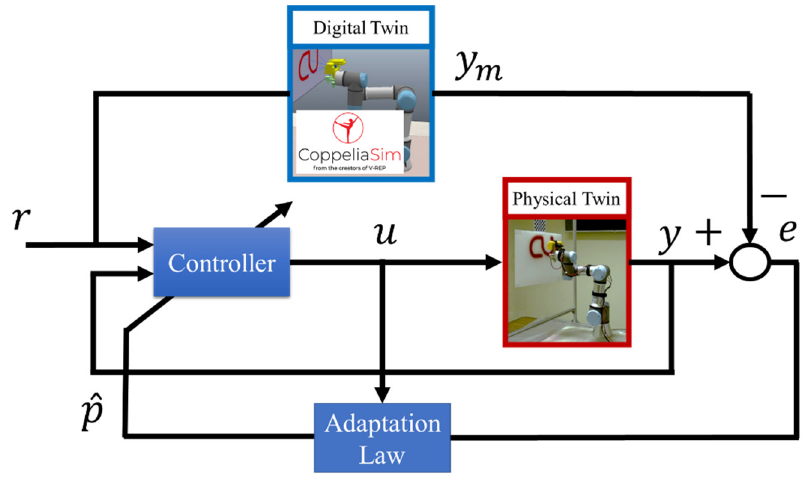
Figure 3. Model Reference Adaptive Control Concept .